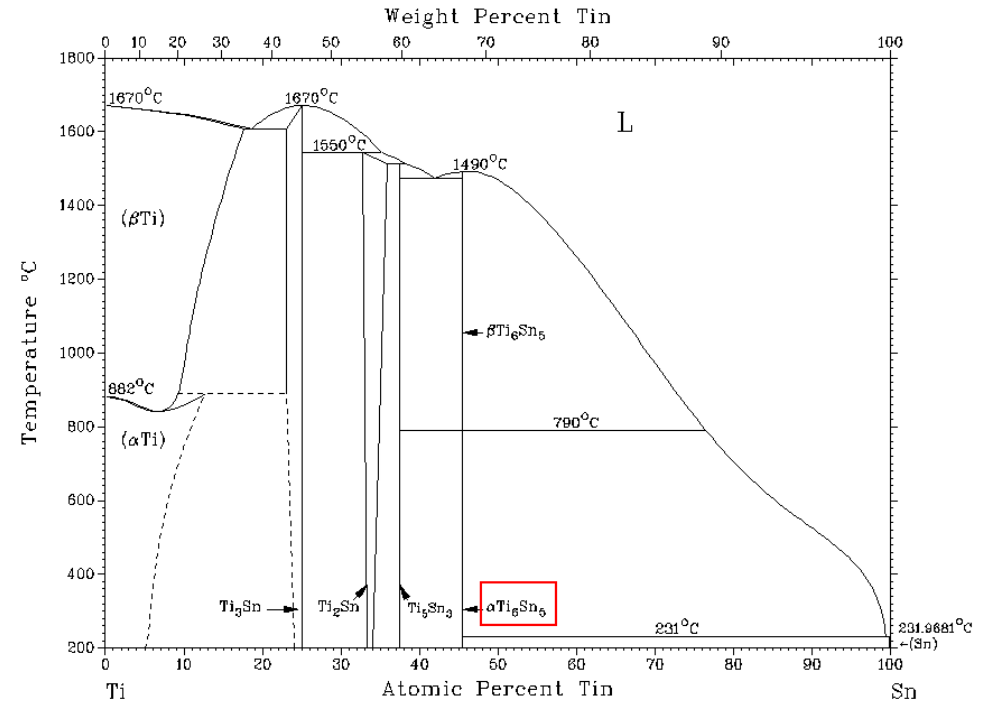
Figure 9. Equilibrium binary diagram of the tin-titanium system [39]. The red box indicates the phase identified in the Figure 9 . Equilibrium binary diagram of the tin-titanium system [39] . The red box indicates the phase identified in the solder solder structure .